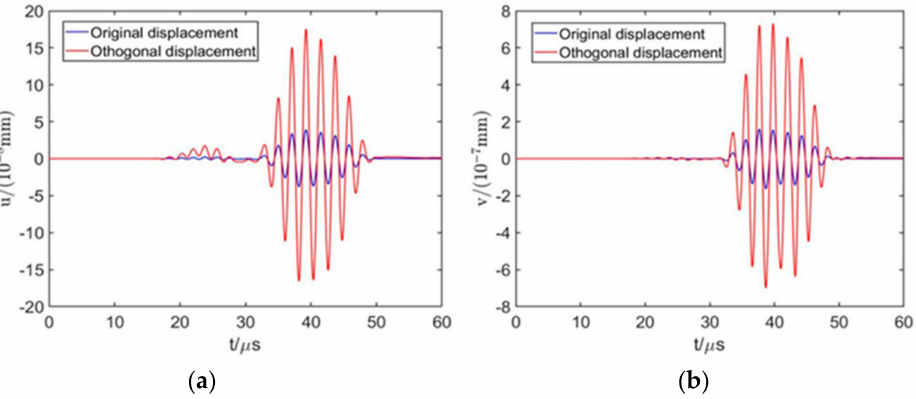
Figure 7. Comparison of surface waves between original and orthogonal EMATs. ( a ) In-plane displacement and ( b ) out-of-plane